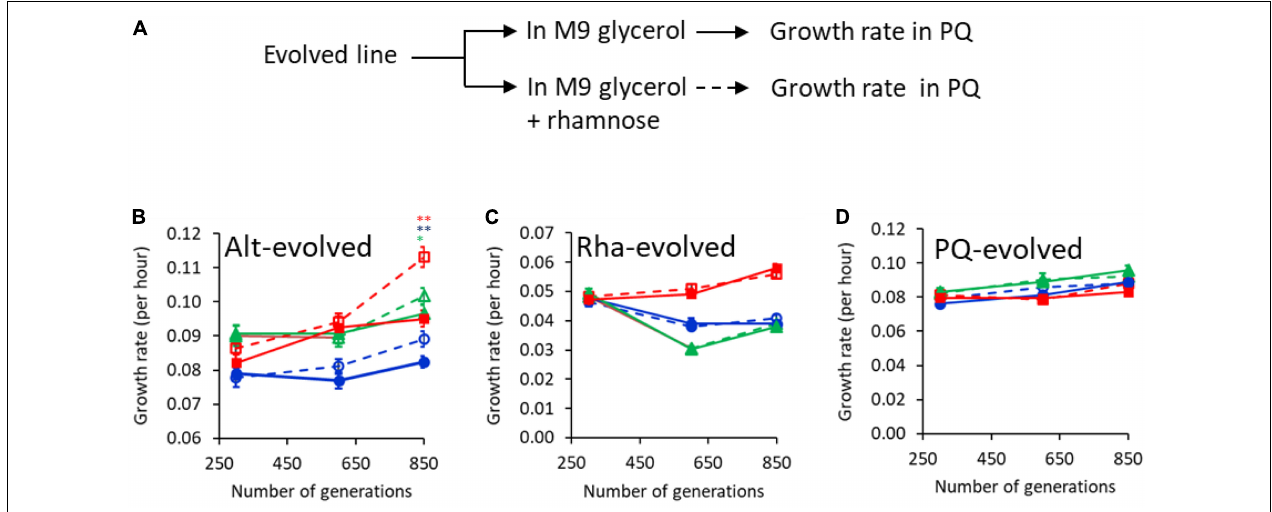
FIGURE 5 | Growth advantage because of evolution of anticipatory regulation takes place around and after 600 generations into the experiment. (A) Experimental design. Evolved lines were grown in M9 glycerol and M9 glycerol containing rhamnose separately. The two cultures were transferred to M9 media containing PQ, and growth kinetics monitored. Growth rate of lines 1 (blue), 2 (green), and 3 (red) in rhamnose-PQ alternating conditions (B) , rhamnose-only (C) , and PQ only (D) . Solid and dashed lines represent growth rates of the lines, when transferred from M9 glycerol medium without or with rhamnose, respectively. (* represents p -value < 0.1; ** represents p -value < 0.0.1 in two-tailed, paired t -test).